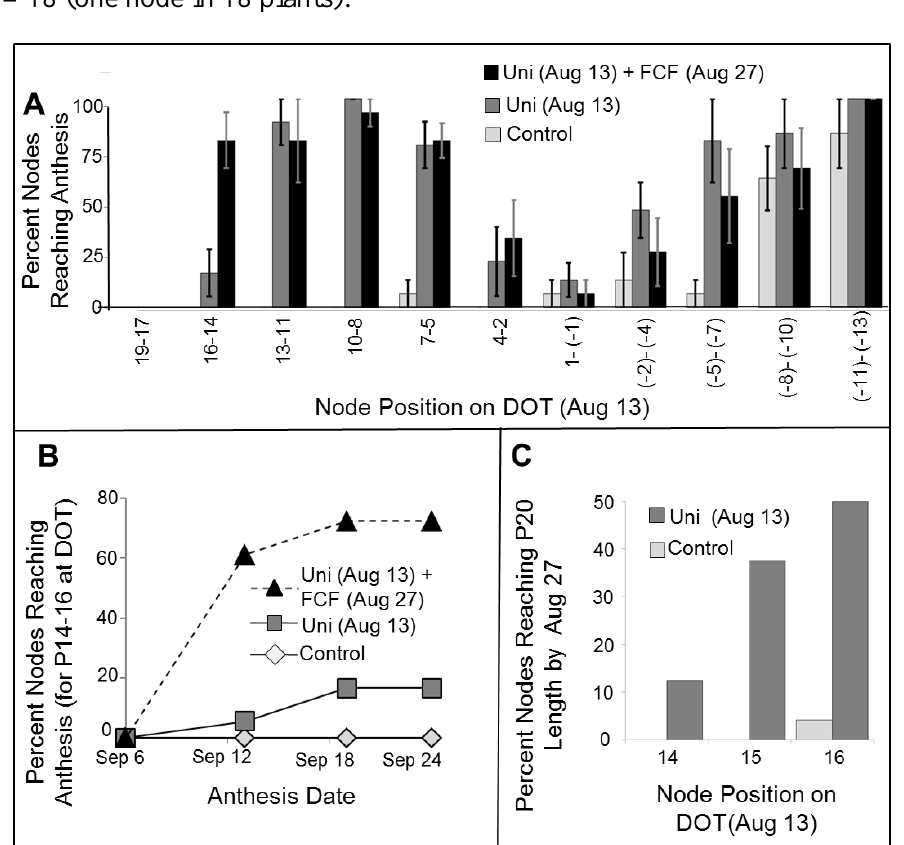
Figure 2. Uniconazole (Uni) and forchlorfenuron (FCF) application on one-branched pot-grown PD plants (2009). The plants were grown under local end of summer conditions, in a net house (see Section 3.3). Treatments: plants sprayed with 200 ppm Uni on August 13 (DOT) or plants sprayed with 200 ppm Uni on August 13 and with 10 ppm FCF on August 25. Control plants were sprayed with water plus surfactant at DOT. Each treatment contained 5–6 plants. ( A ) Percent flower primordia reaching anthesis, per node position on DOT; bars represent the standard error of the mean. Node positions depicted as negative were not formed yet on DOT; ( B ) Anthesis date of P14–P16 (position on DOT) primordia. Control plants did not have developed flowers at these positions, and the first anthesis in control plants occurred on a later date (October 10). The additional FCF treatment caused a higher rate of flowers reaching anthesis at these positions, on an earlier date. For each treatment, the fate of 18 nodes (three nodes in six plants) was followed, and the percent of nodes reaching anthesis was calculated; ( C ) The short-term fate of nodes that were at P14–P16 on DOT, measured two weeks later (August 27). We measured the percent of primordia reaching a length of more than 24 mm, corresponding to normal primordia at P20. Reaching a length similar to P20 is not proof that the primordium is intact. n = 18 (one node in 18